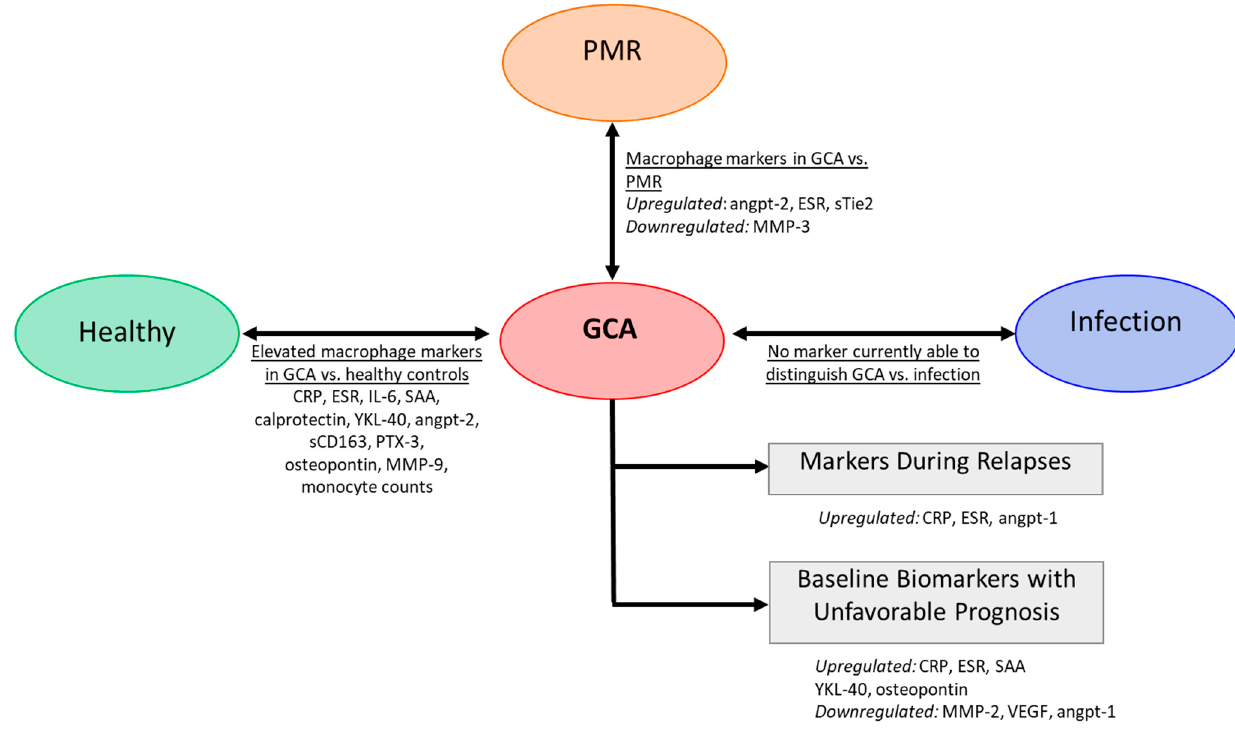
Figure 3. Serum markers in GCA. Several markers are altered in GCA compared to healthy controls. Some studies reported markers to differentiate GCA patients from patients with isolated polymyalgia rheumatica (PMR). There is currently no macrophage markers to discriminate between GCA and infection (e.g., respiratory and urinary infection) [51,104–112].